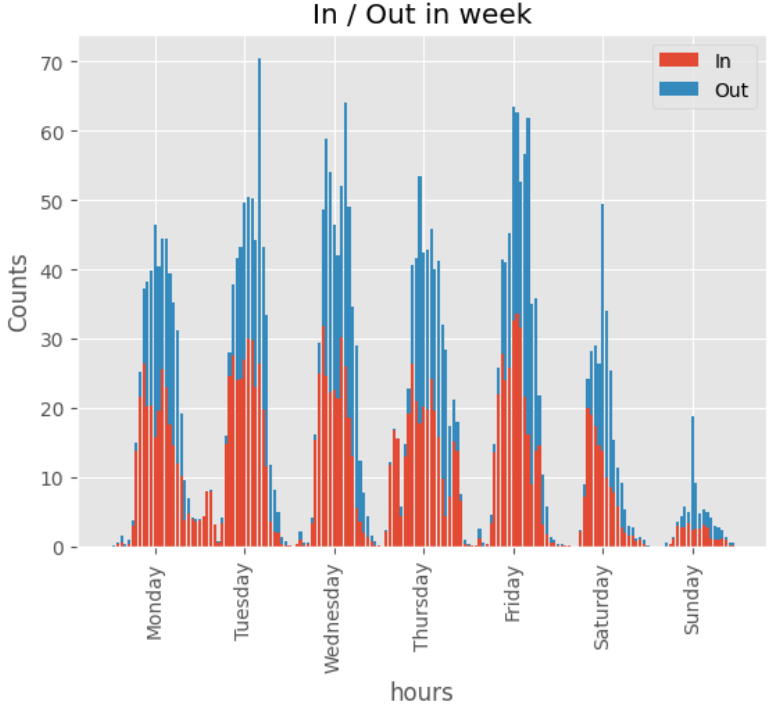
Figure 4. Weekly in and out arrival from 1 November 2020 to 7 November 2020 at Location A.